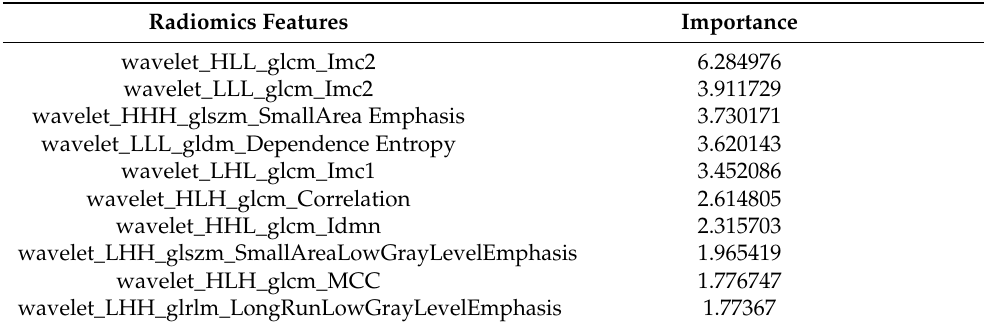
Table 1. Top ten Random Forest feature importance for diagnosis of bone marrow involvement of multiple myeloma.